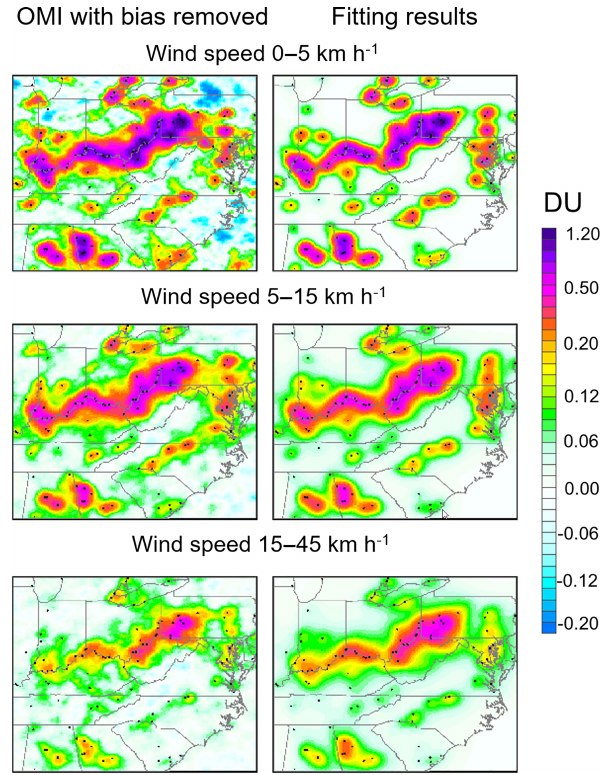
Figure 4. Left: mean OMI SO 2 VCDs grouped by wind speed with a large-scale bias removed. Right: results of the fitting of OMI data by the set of functions that represent VCDs near emission sources using estimated emissions. While the fitting was done us- ing all data, the results of the fitting are grouped by wind speed. Averages for 2005–2007 binned by the wind speed (0–5, 5–15, and 15–45kmh − 1 ) are shown. Sources that emitted 20ktyr − 1 at least once in 2005–2015 were included in the fit (they are shown as black